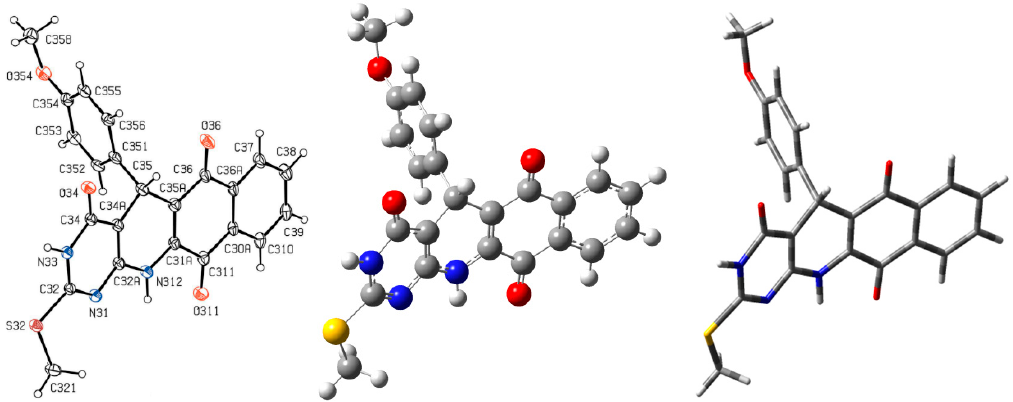
Figure 2. X-ray structure of 5-(4-methoxyphenyl)-2-methylthio-5,12-dihydrobenzo[ g ]pyrimido[4,5- b ]quinoline-4,6,11(3 H )-trione 4c : ( Left ) ORTEP (Oak Ridge Thermal Ellipsoid Plot diagram), displacement ellipsoids are drawn at the 30% probability level. ( Middle ) The optimized structure with B3LYP/6-31G(d,p) level, ball and bond type. ( Right ) The optimized structure with B3LYP/6-31G(d,p) level.